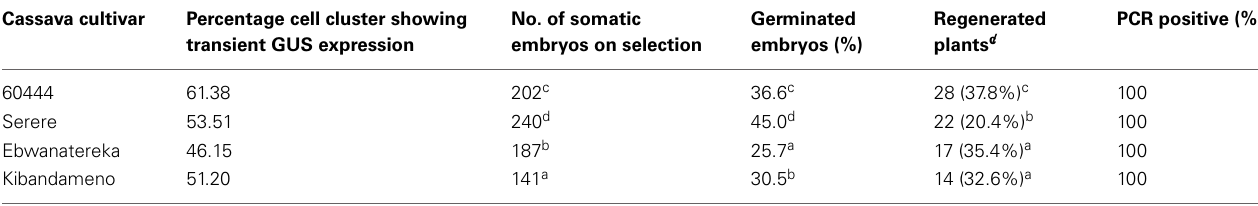
Table 4 | Regeneration and validation of transgenic plants of various cultivars of cassava using FECs ∗ . Cassava cultivar